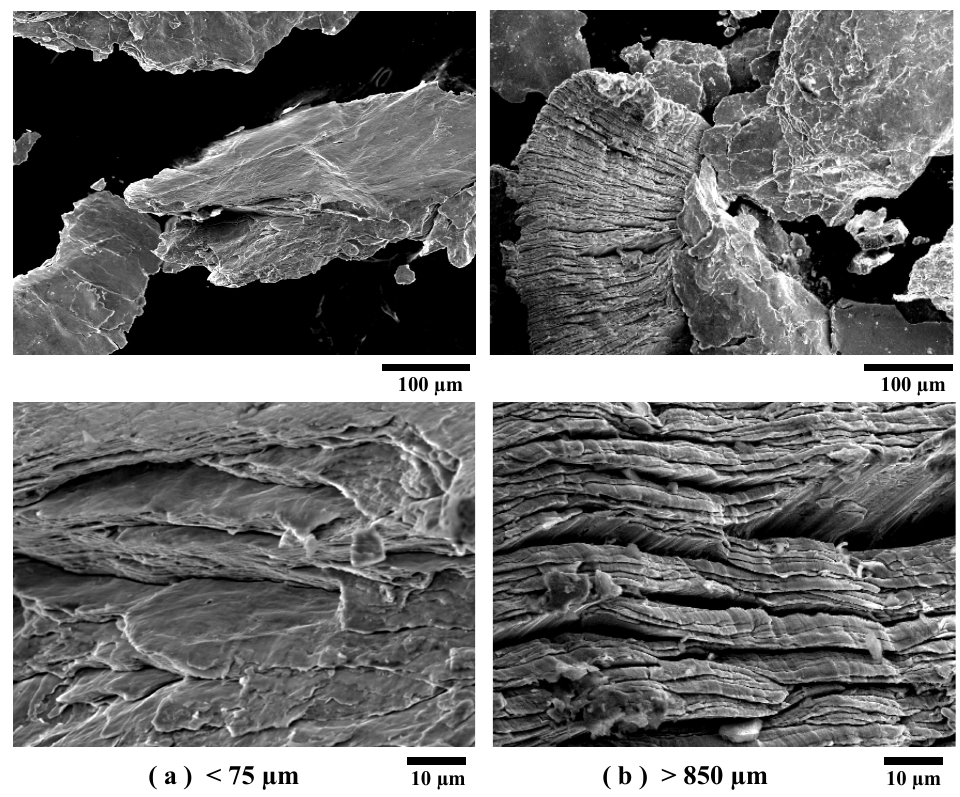
Figure 5. Morphologies of the ( a ) under 75 and ( b ) over 850 µm pulverized Al/Ni multilayer powders observed by a secondary electron (SE) detection mode of FE-SEM.